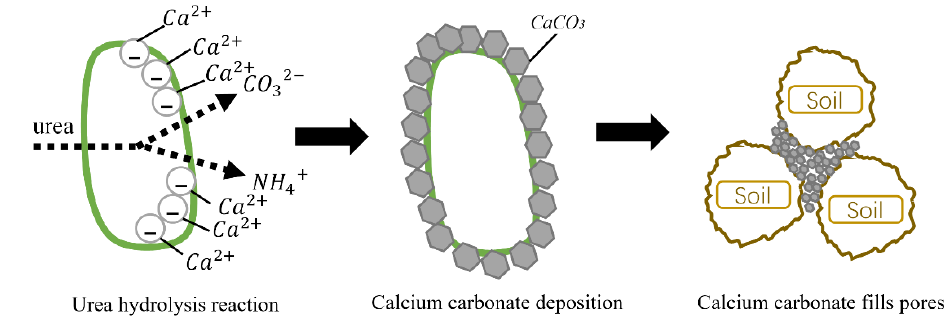
Figure 3. Microbially induced calcite precipitation (MICP) mechanism.